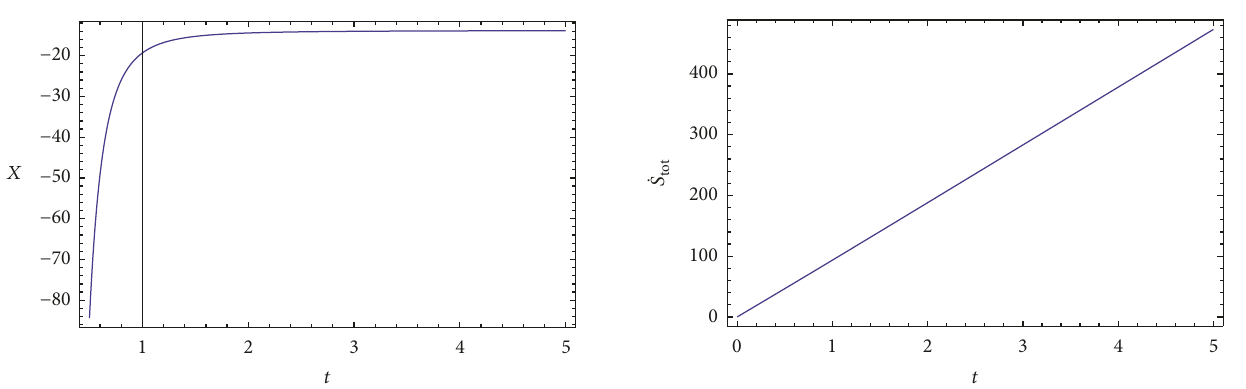
̇𝑆 Figure 5: Plot of tot by taking Renyi entropy as entropy at apparent horizon, where time is measured in